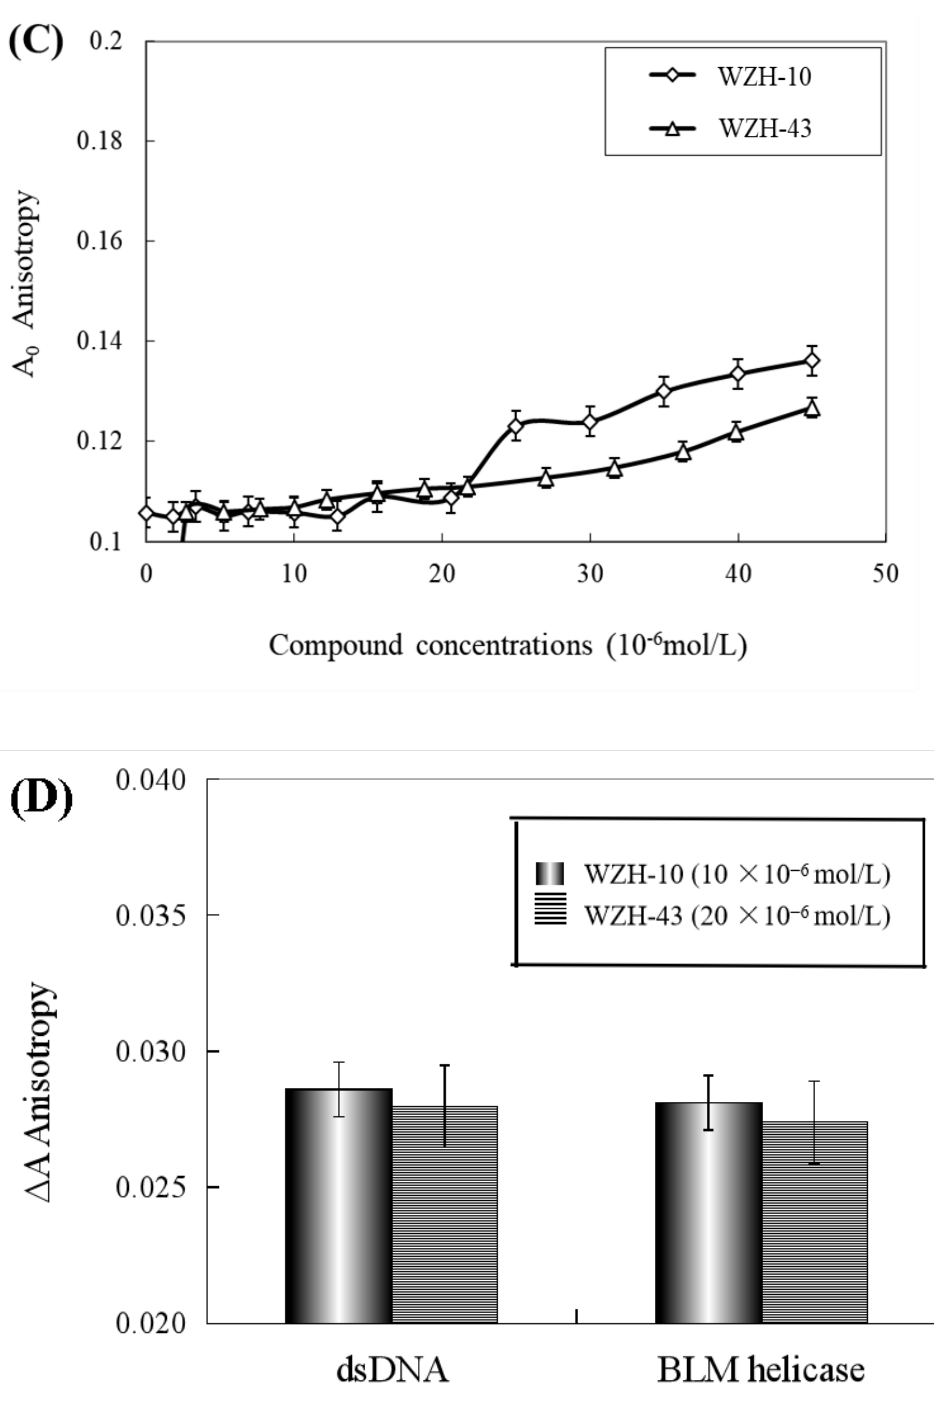
Figure 5. Effect of WZH-43 ( A ) and WZH-10 ( B ) on the DNA-binding activity of BLM helicase bound to dsDNA and on the anisotropy of dsDNA ( C ) and ssDNA ( D ). A 0 : fluorescence anisotropy of the fluorescein-labeled DNA. A 1 : fluorescence anisotropy of the miscible liquid of the helicase at different concentrations of WZH-43 and WZH-10.